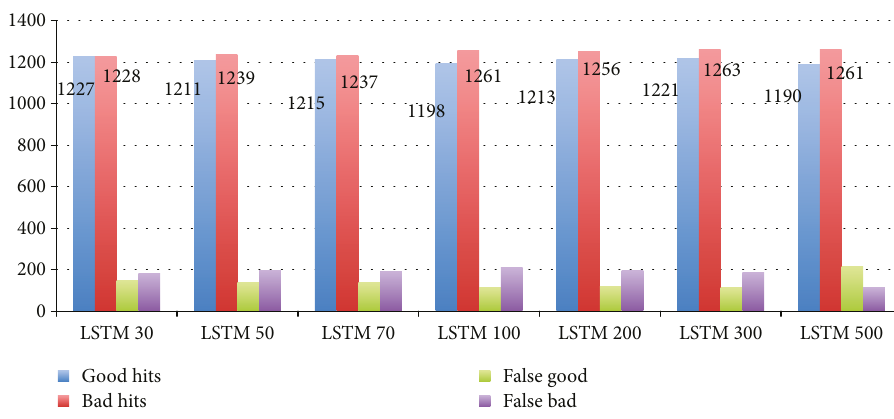
Figure 8: LSTM comparison.